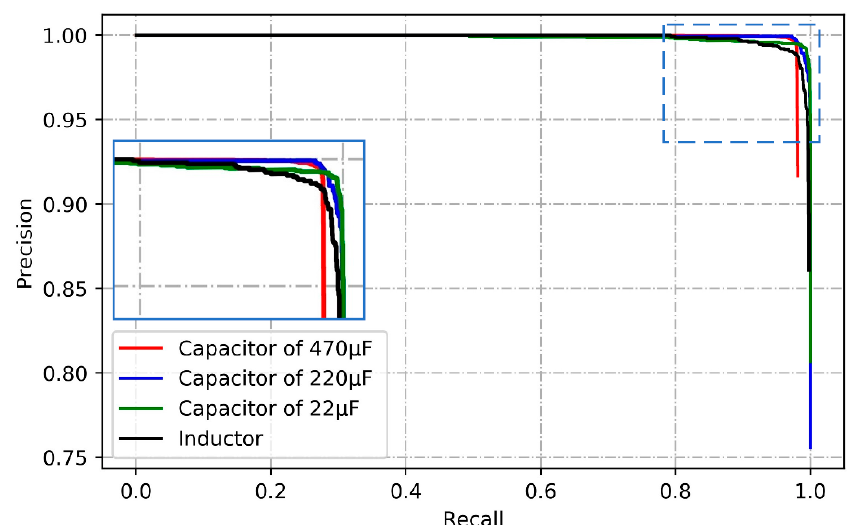
Figure 10. Precision and recall (P–R) curves of the four electronic components.